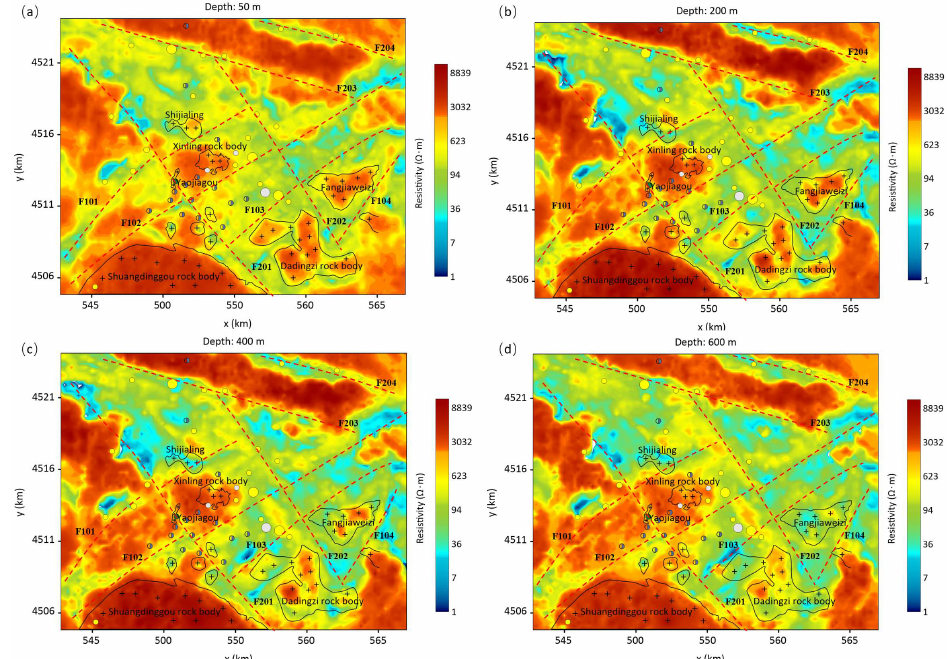
Figure 11. Resistivity slices at different depths, and the known surface rock mass geological data are projected onto the slices at each depth, as shown by black lines. The red dotted line is the fault or fracture inferred from the resistivity model. The northeast trending fault is named after the F1 prefix, and the northwestern fault is named after the F2 prefix. ( a ) Inversion result at 50 m. ( b ) Inversion result at 200 m. ( c ) Inversion result at 400 m. ( d ) Inversion result at 600 m.